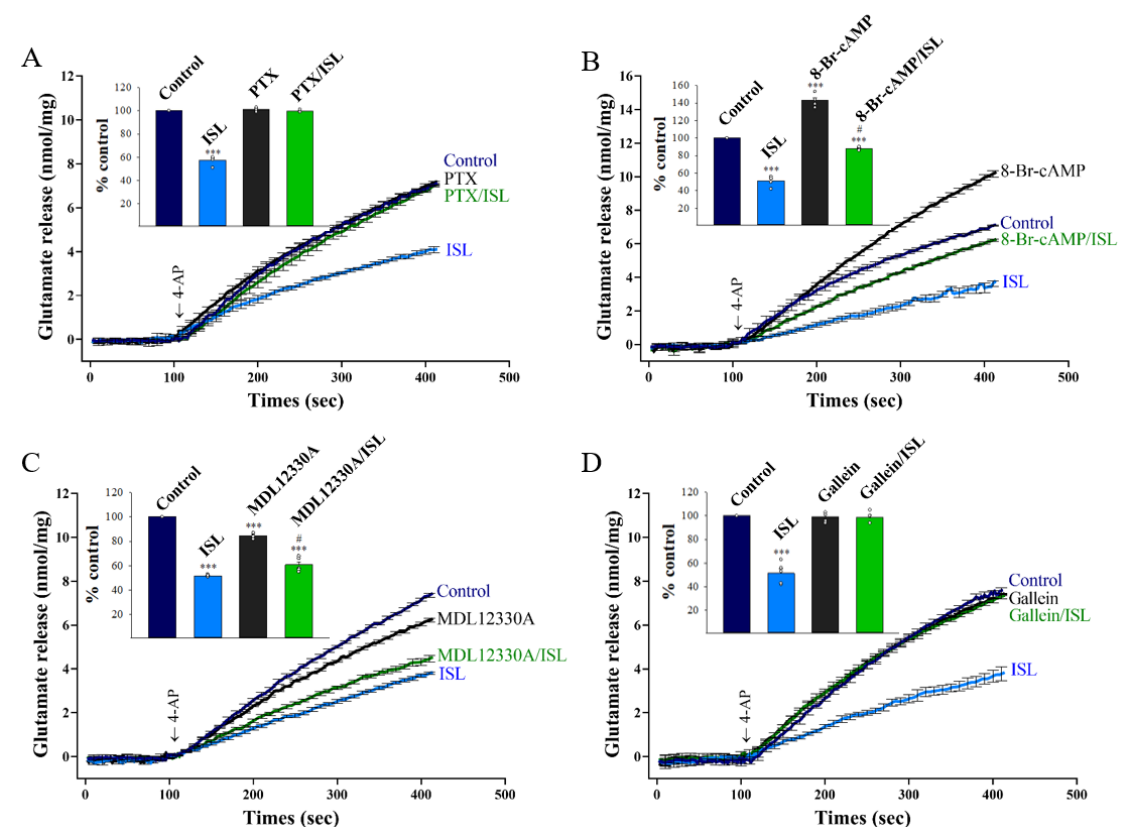
Figure 6. G βγ is involved in ISL-mediated inhibition of glutamate release. 4-AP-evoked glutamate release from synaptosomes incubated in the absence (control) or presence of 10 µM ISL, 2 µg/mL PTX, or both ( A ); or 10 µM ISL, 250 µM 8-bromo-cAMP, or both ( B ); or 10 µM ISL, 10 µM MDL12330A, or both ( C ); or 10 µM ISL, 10 µM gallein, or both ( D ). Insets compare the effects of PTX, 8-bromo-cAMP, MDL12330A, or gallein on 4-AP-evoked glutamate release, or the inhibition by ISL (% control release 5 min after 4-AP addition). Data are the mean ± SEM (n = 5 per group). ***, p < 0.001 versus the control group; #, p < 0.05 versus the 8-bromo-cAMP- or MDL12330A-treated group.